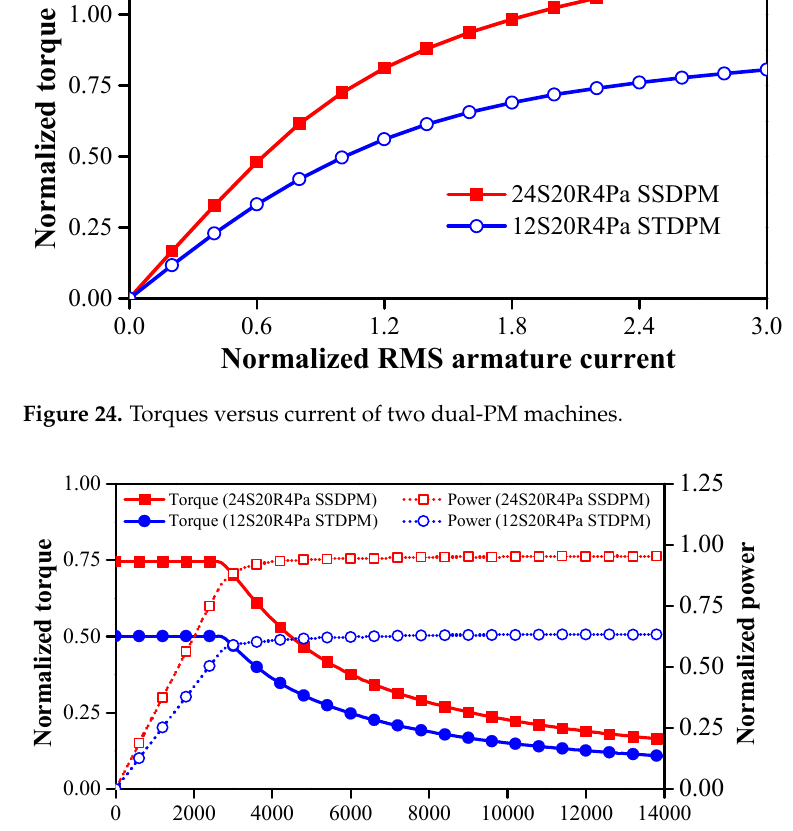
Table 5. Comparison of electromagnetic performances of two dual-PM machines under 600 rpm and the same copper loss.